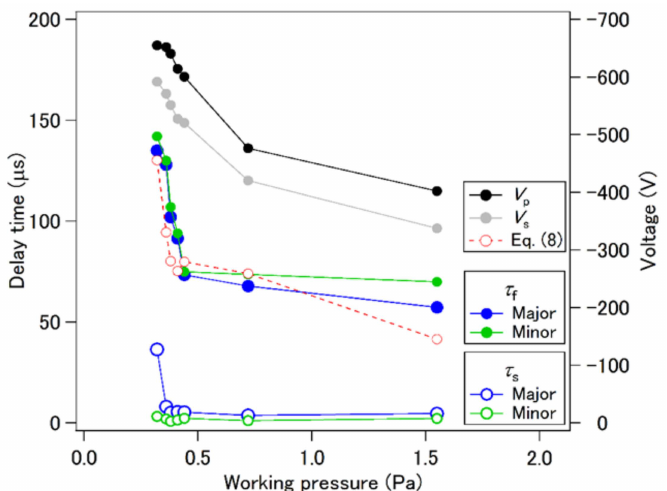
Figure 9. Formative times τ f (solid circles) and statistical times τ s (open circles) in MPPMS discharge as a function of argon pressure in the range of 0.32 to 1.55 Pa. The major and minor components are colored blue and green, respectively. Maximum breakdown voltages V p (black solid circles), minimum breakdown voltages V s (gray solid circles), and the voltage factors given by these voltages (red open circles) in MPPMS discharge as a function of argon pressure in the range of 0.32 to 1.55